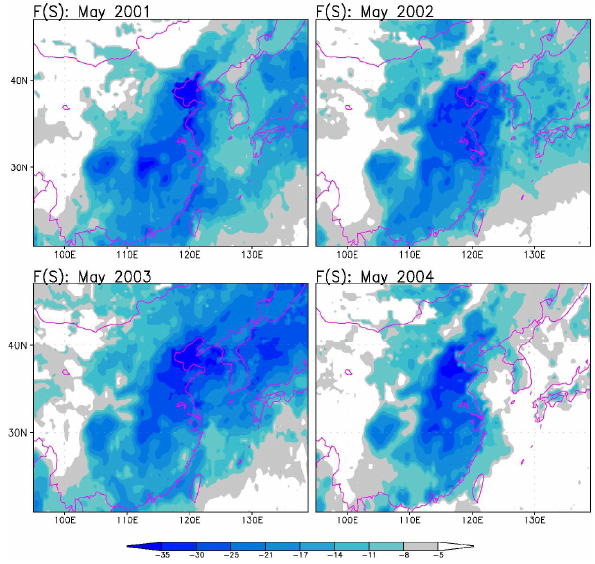
Fig. 13. Anthropogenic aerosol forcing at the surface in units of Wm − 2 . Figure 13. Anthropogenic aerosol forcing at the surface in units of Wm − 2 .